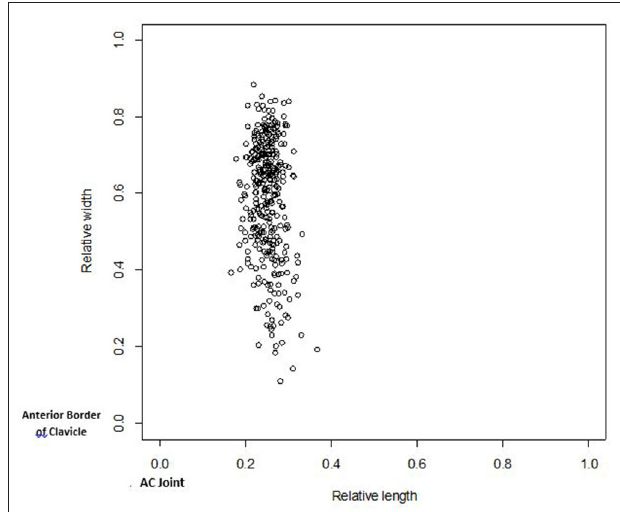
FIGURE 3 | CC facet midpoint along width vs. midpoint along length. The midpoint of the facet along the width of the clavicle (relative to the width of the clavicle) is plotted vs. the midpoint of the facet along the length of the clavicle (relative to the length of the clavicle). The scale of 0–1 represents the entire length and width of the clavicle. For relative width, 0 is the anterior border and 1 is posterior border. For relative length, 0 is the point at the acromicoclavicular end and 1 is at the sternoclavicular end. Black circles are males, white circles are